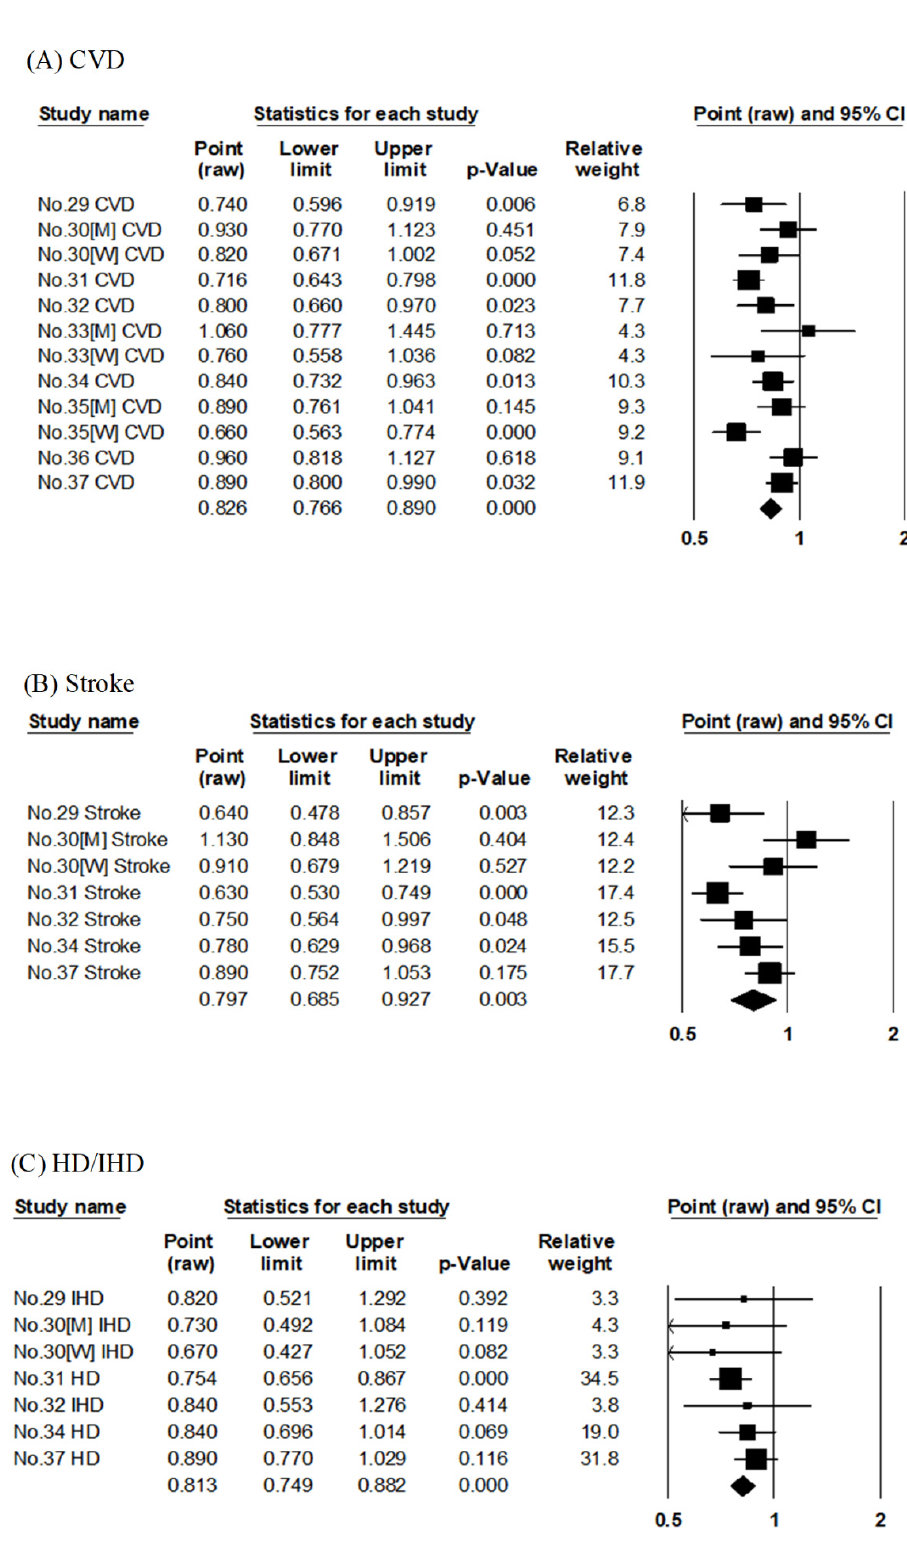
Figure 2. Meta-analysis of the Japanese-style dietary pattern and mortality risk. ( A – C ) show the association between the Japanese-style dietary pattern and CVD, stroke, and HD/IHD mortality risk, respectively. The area of each square is proportional to the study weight. Horizontal lines represent 95% confidence intervals. Diamonds represent pooled estimates from inverse-variance- weighted random-effects model. The number given in the study name indicates that of the cited reference [29–32,34,37]. CVD; cardiovascular disease, HD/IHD; heart disease/ischemic heart